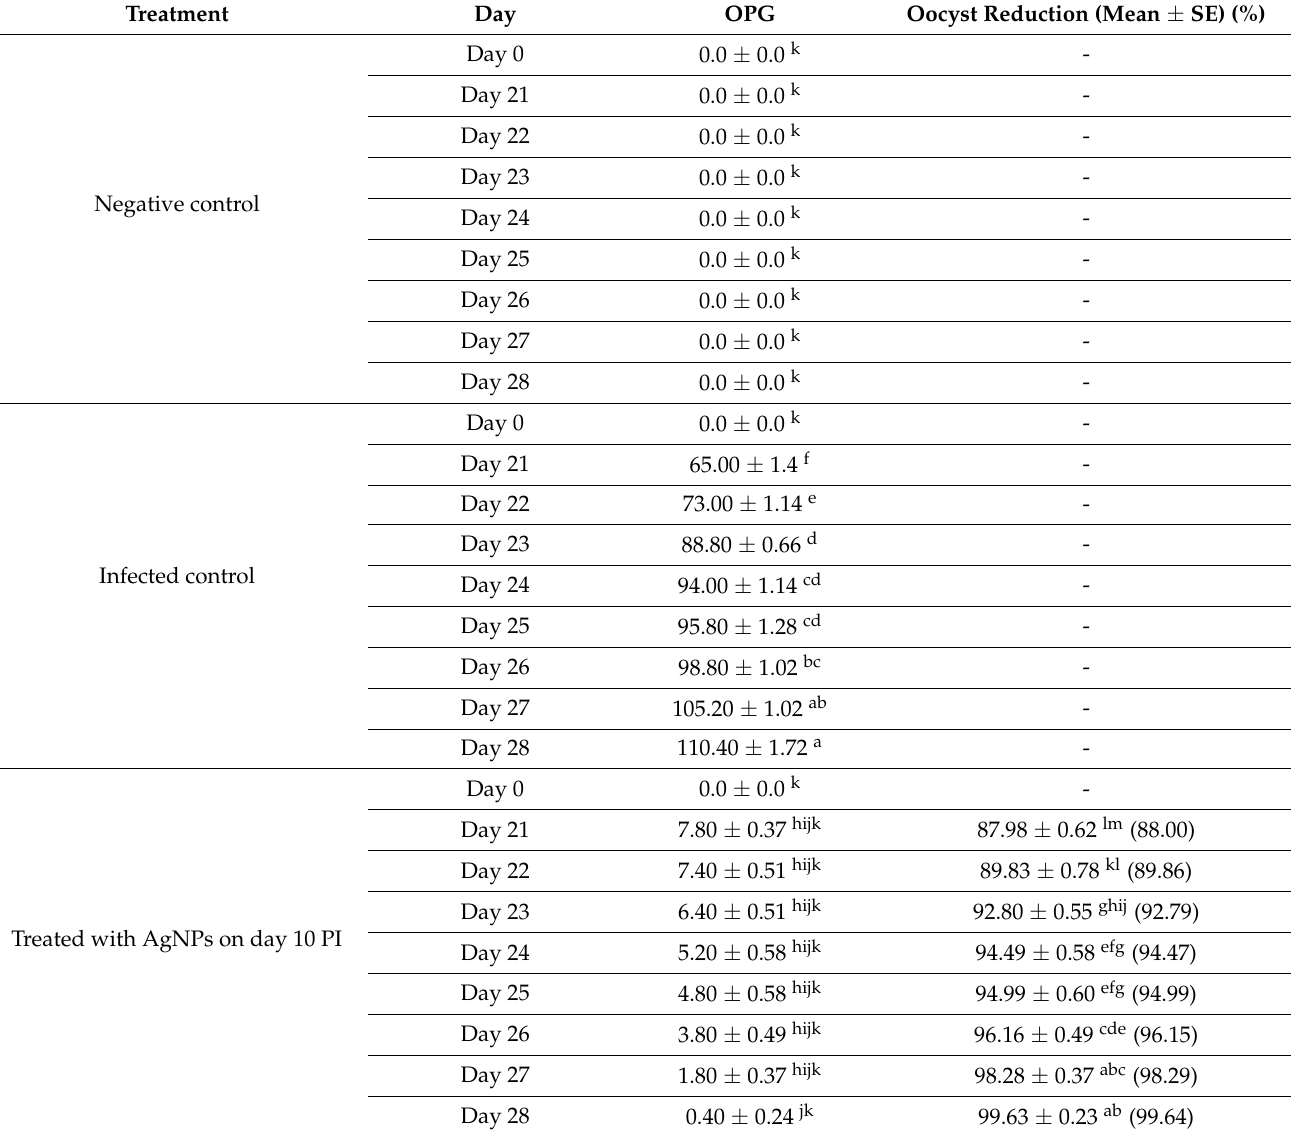
Table 3. Effects of the different treatments on the oocyst count/gram feces (OPG) and reduction percent (%) in rabbits infected with E. stiedae